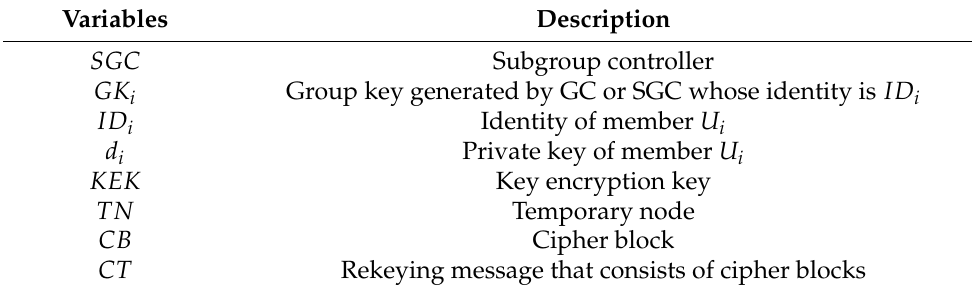
Table 1. Summary of notation in the